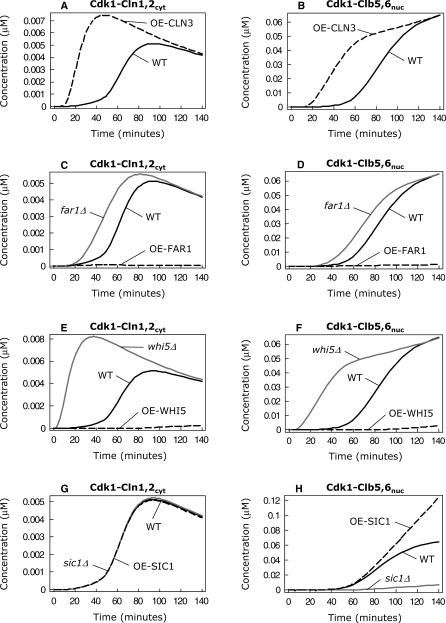
Model Predictions of Gene Dosage EffectThe effects on Cdk1-Cln1,2cyt (left panels) and Cdk1-Clb5,6nuc levels (right panels) are compared with wild-type cells. In each panel, wild-type is shown in black, deletion mutants in gray, and overexpressed strains as a dotted line.(A,B) CLN3 overexpression (OE-CLN3).(C,D) FAR1 deletion (far1Δ) and overexpression (OE-FAR1).(E,F) WHI5 deletion (whi5Δ) and overexpression (OE-WHI5).(G,H) SIC1 deletion (sic1Δ) and overexpression (OE-SIC1).